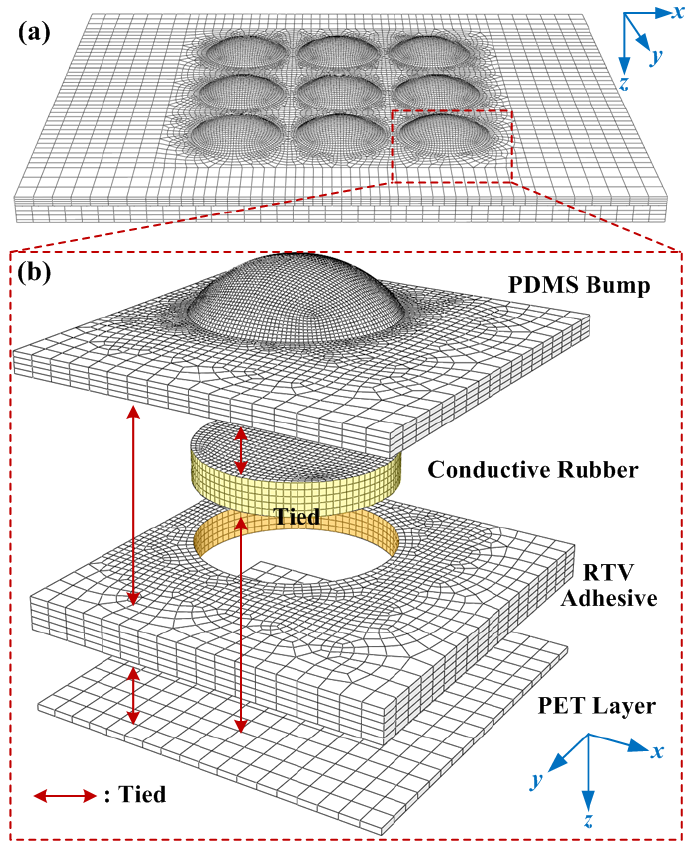
Figure 2. ( a ) 3D finite element modeling (FEM) model of flexible tactile sensor array; ( b ) Close-up view of sensing unit.